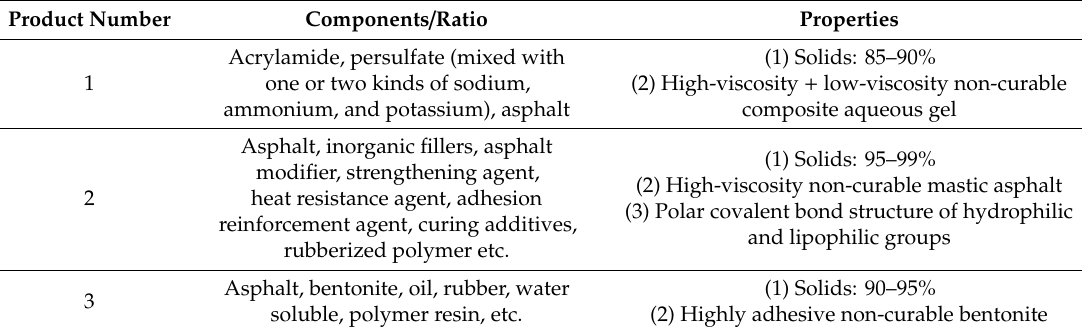
Table 5. The Synthetic rubber polymer gel (SRGP) injection grout material